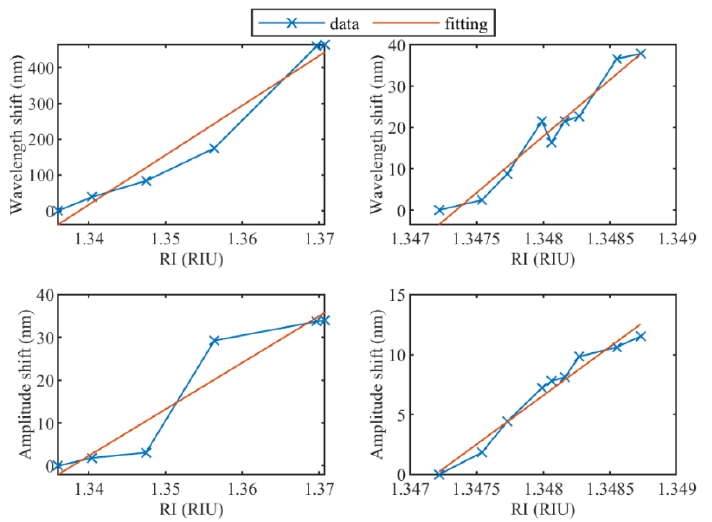
Figure 6. ( left ) Amplitude and wavelength shift for the high RI range from 1.33679 RIU to 1.37078 RIU of unetched TFBG; ( right ) Amplitude and wavelength shift for the small RI range from 1.34722 RIU